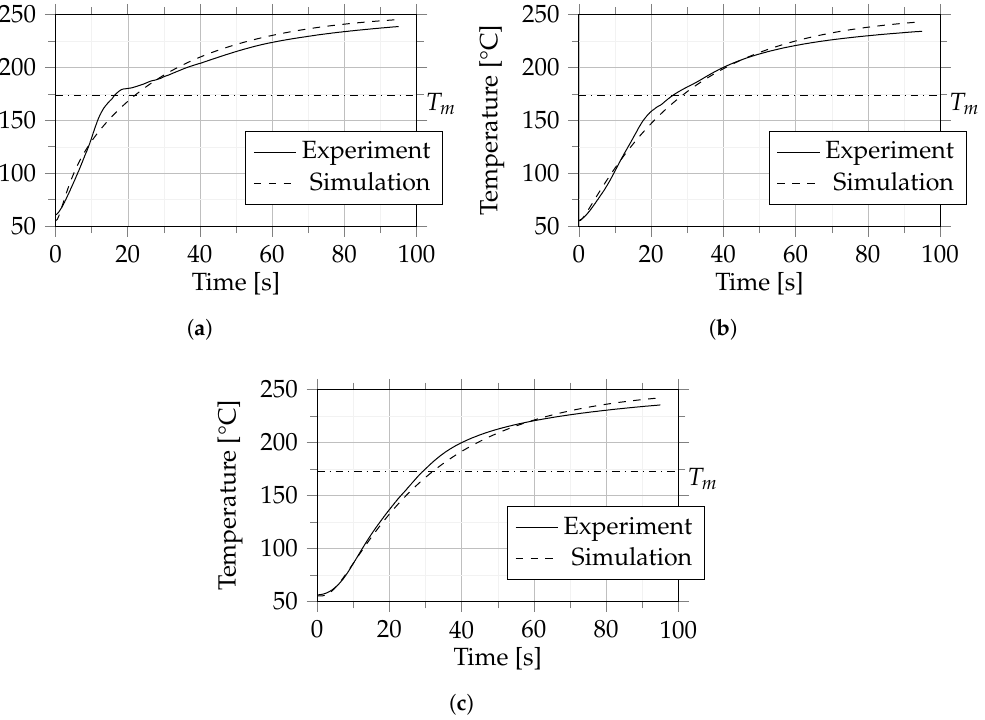
Figure 14. Case 5: Comparison between experiment and simulation in terms of temperature between layers 1 and 2 ( a ), 9 and 10 ( b ) and 17 and 18 ( c ). The dash-dotted line indicates the melting temperature ( T m ) of 173